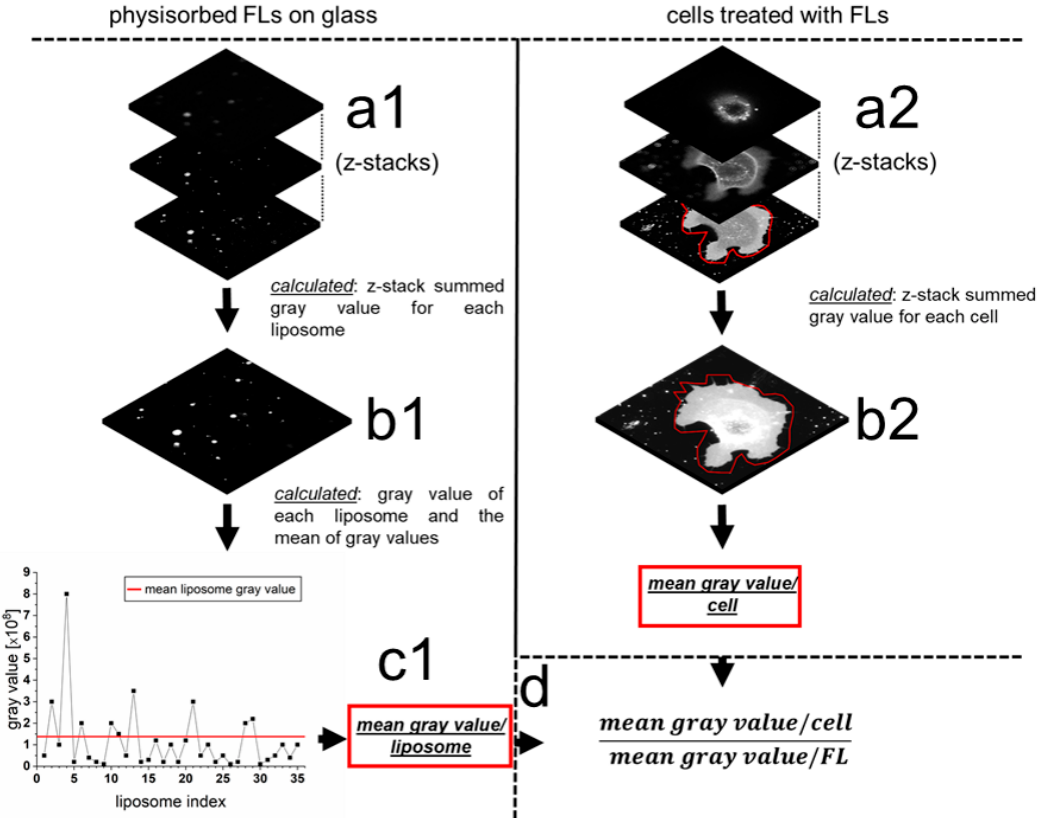
Figure 5. Schematic overview of the membrane fusion events quantification. The fluorescence signal of mRNA loaded FLs adsorbed on glass was recorded in 3D in the red channel (DiR) ( a1 ). Gray values of the z-stacks were summed up for each individual liposome ( b1 ). In addition, a mean gray value of all detected liposomes was calculated ( c1 ). Subsequently, nHEK cells, previously treated with protamine/eGFP–mRNA/FL complexes, were imaged in 3D ( a2 ), and gray values of the z-stacks were summed up for each single cell ( b2 ). Liposomal gray values were analyzed in 12 independent measurements with 900 liposomes in total and compared with mean gray values of 15 cells. Using the values calculated in ( c1) and ( b2) , the total number of liposomes fused with a single nHEK cell was calculated ( d ). FL = fusogenic liposome.